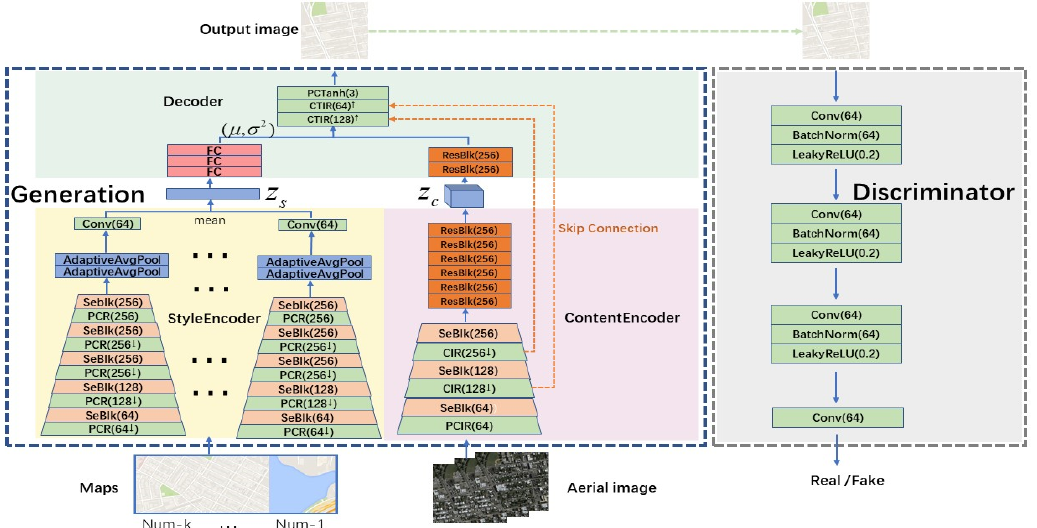
Figure 2. Detailed architecture of the SAM-GAN model, where PCR represents the combination of Padding, Convolution, and ReLU activation functions; SeBlk represents the attention module, PCIR represents the combination of Padding, Convolution, Instance Normalization, and ReLU activation functions; FC represents the fully connected layer; CTIR represents the Transpose Convolution, Instance Normalization, and ReLU combination; Z S denotes the style potential coding vector, and Z C denotes the content potential coding feature map.